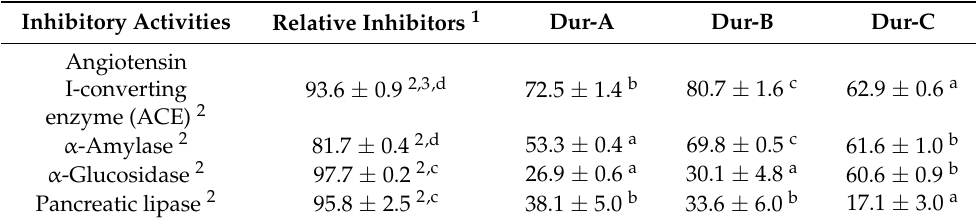
Table 3. Inhibitory activities against key metabolic syndrome-related enzymes of Dur-A, Dur-B, and